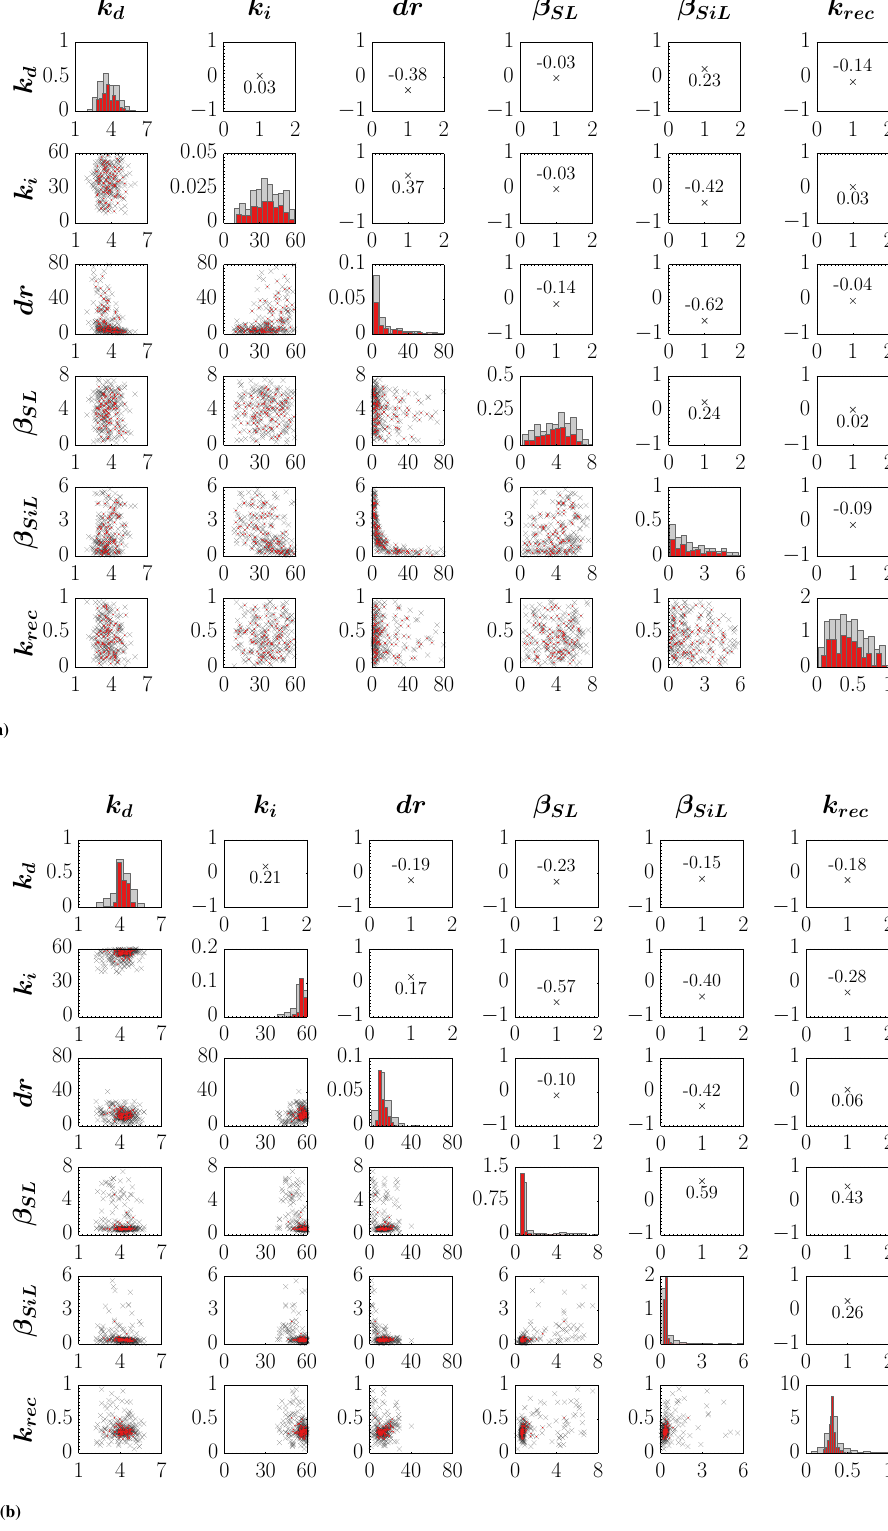
Fig. 14: Distribution of the model parameter vectors estimated by A-ROPE (a) and ROPE-PSO (b).